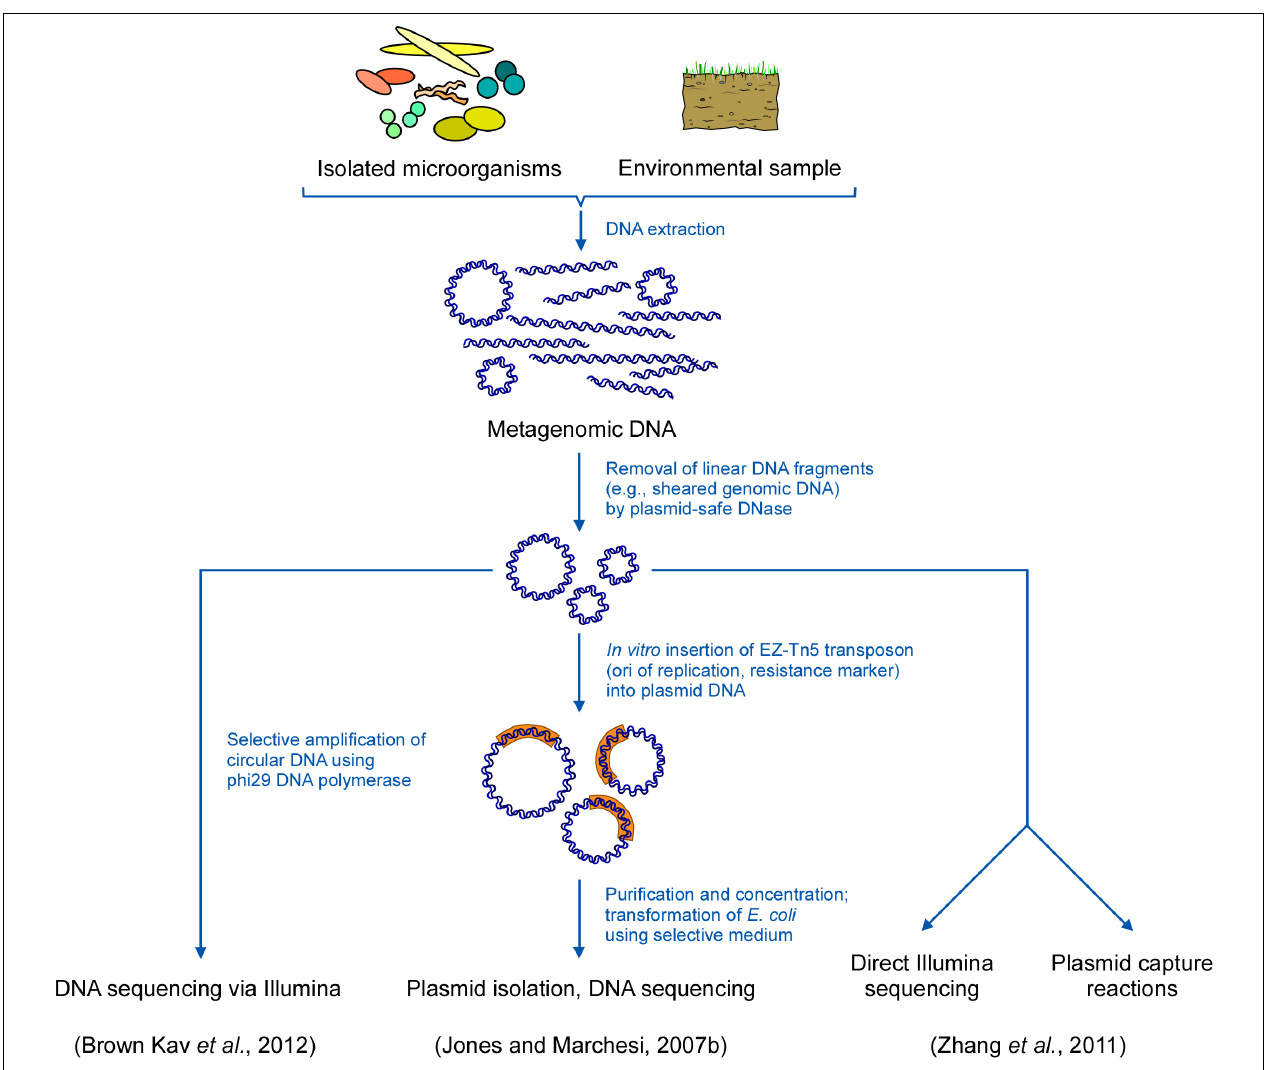
FIGURE 1 | Schematic representation of strategies for metagenomic studies of extrachromosomal DNA